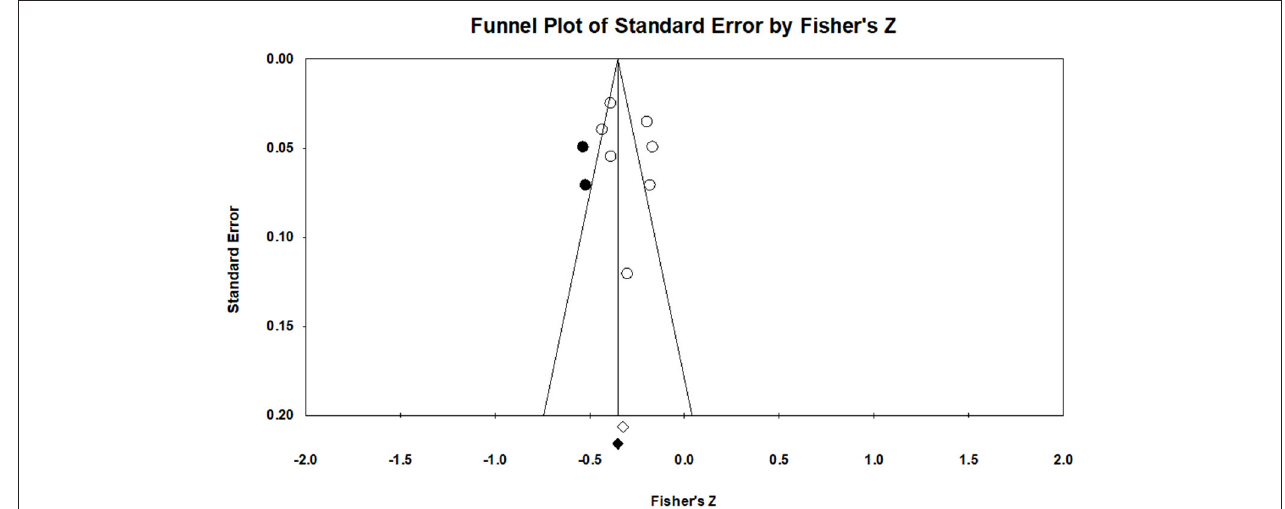
FIGURE 5 | Funnel plots of